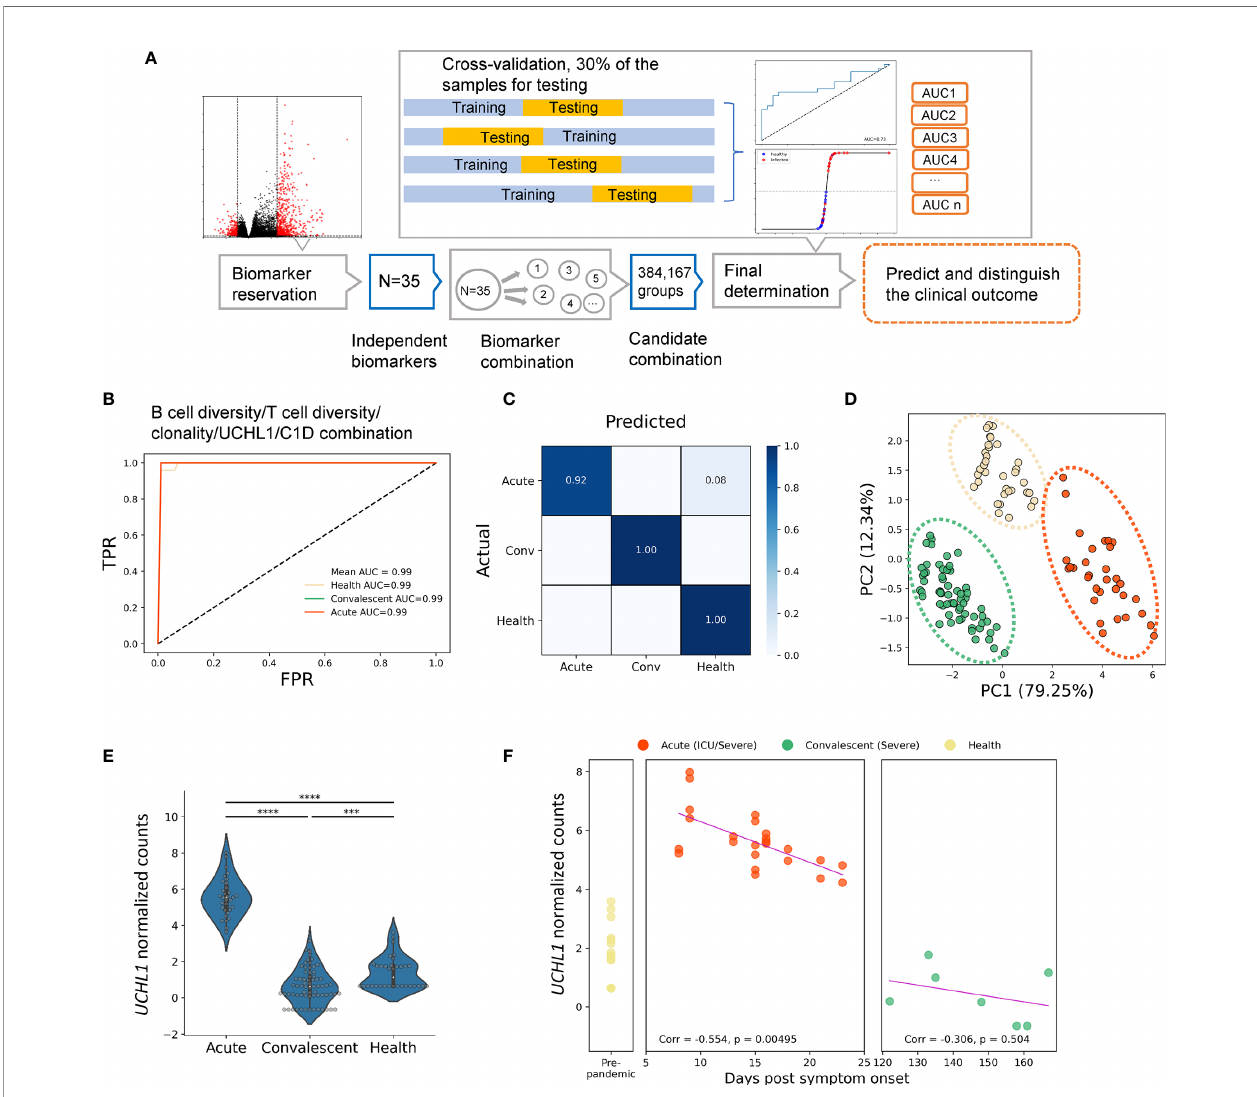
FIGURE 3 | Identi fi cation of biomarkers for classifying and predicting clinical outcomes of SARS-CoV-2 infection by machine learning strategy. (A) The experiment design of the prediction pipeline; cross-validation was involved for model training. DEG, differentially expressed genes. The best biomarker combination determined by the pipeline: (B) the ROC curves, (C) the confusion matrix, and (D) PCA analysis for the best biomarker combination, which was more accurate and sensitive than independent biomarkers. (E) Normalized UCHL1 expression in acute, convalescent, and healthy groups. (F) Correlation between normalized values of UCHL1 expression and time from symptom onset to sample collection. The pink line represents the linear regression line. Unpaired two-group comparisons were done with the Mann – Whitney U test. **** P < 0.0001, *** P <